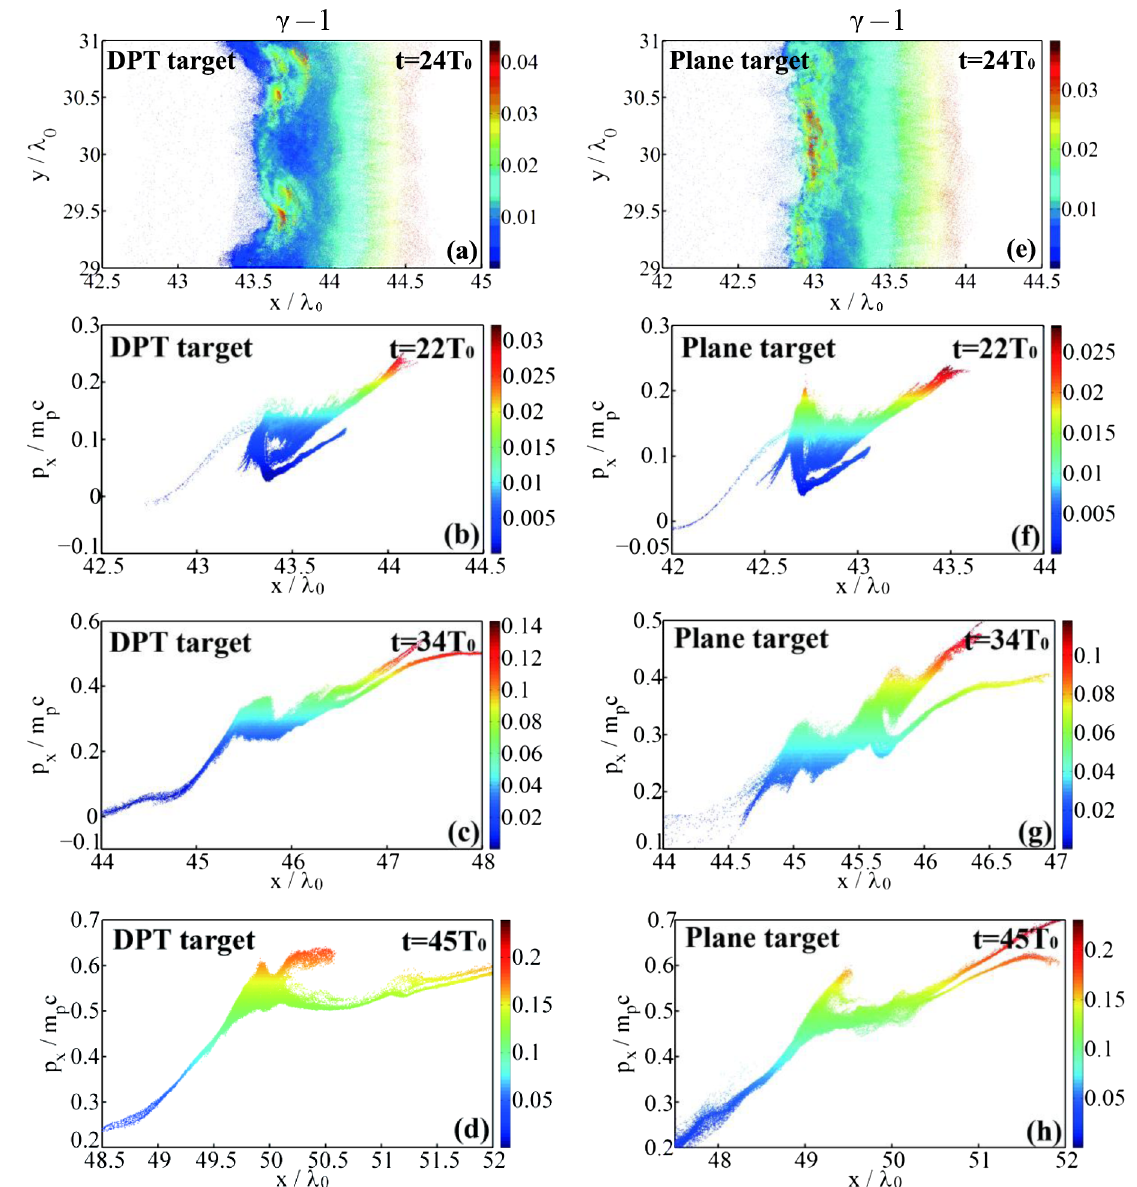
FIG. 3. Parts (a) and (e) are the spatial distributions of the normalized proton kinetic energy (cid:4) (cid:3) 1 in the target central region ( 29 (cid:1) 0 < y < 31 (cid:1) 0 ) at t ¼ 24T 0 for the DPT and plane targets, respectively. Parts (b)–(d) and (f)–(h) are the phase space distributions of the protons at the target central region ( 29 : 75 (cid:1) 0 < y < 30 : 25 (cid:1) 0 ) at different time for the DPT and plane target cases, respectively. The color bar denotes (cid:4) (cid:3) 1 . The initial normalized peak laser amplitude is a ¼ 58 and the target density n ¼ 400 n c